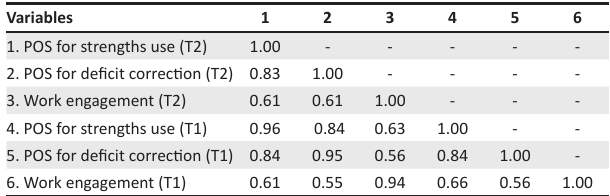
TABLE 3: Correlation matrix for the latent variables. Variables